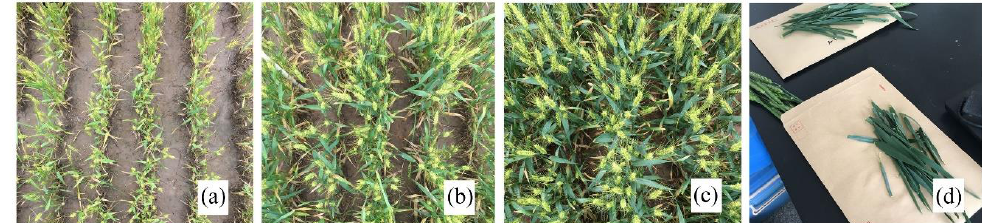
Figure 2. Wheat in experimental plots and wheat leaf destructive sampling for LAI measurements on 15 May 2018: ( a ) N 0 -80%fc in Field D, ( b ) N 140 -80%fc in Field, ( c ) N 280 -80%fc in Field D, and ( d ) Destructive sampling.